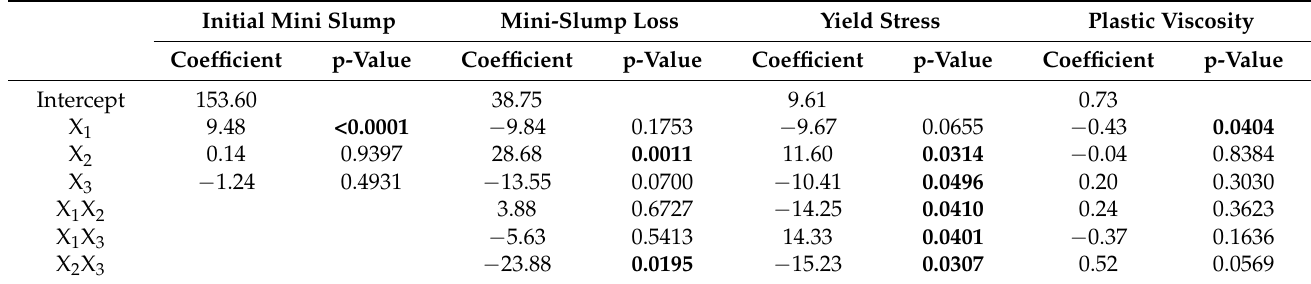
Table 9. Coefficient table for the variables of all